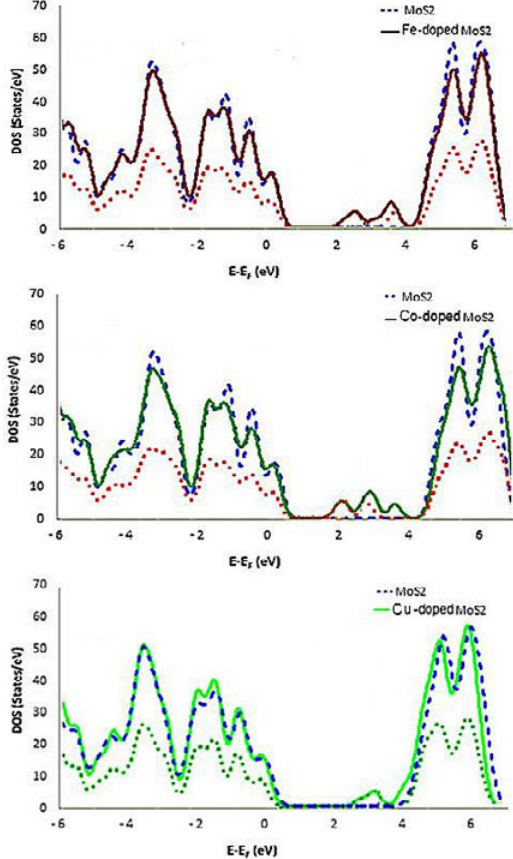
and TM- Fig. 5. Schematic representation of basic steps in designing a 2 nanobiosensor for nucleic acid